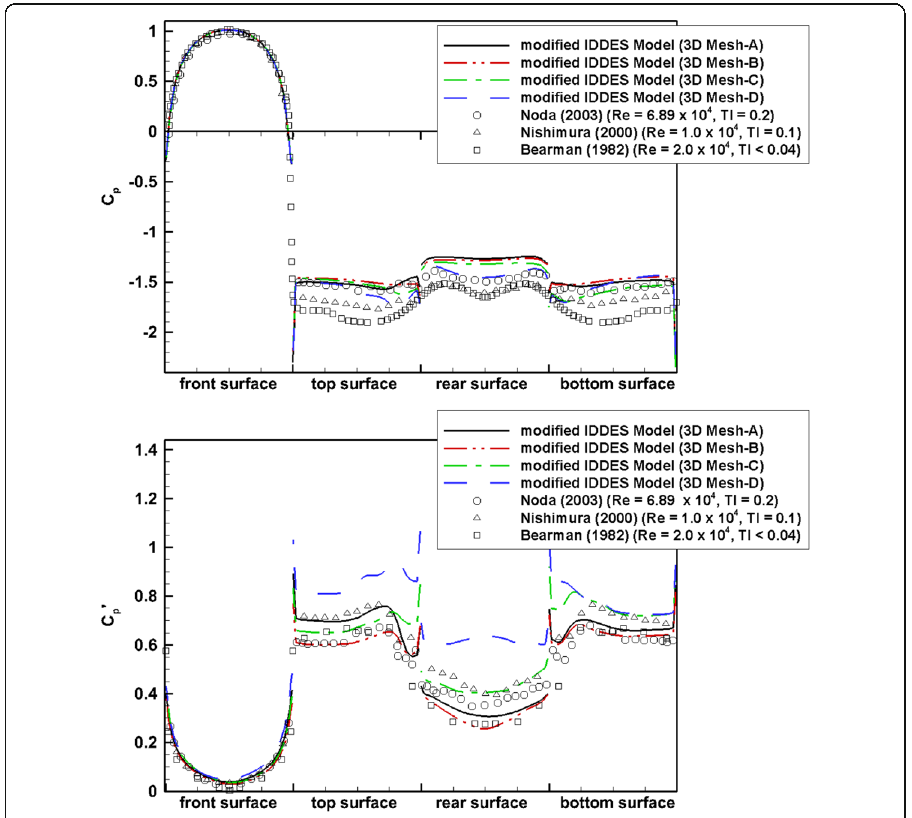
Fig. 11 Surface pressure coefficient distribution (top) and rms pressure coefficient distribution (bottom) by 3D simulations with the modified IDDES